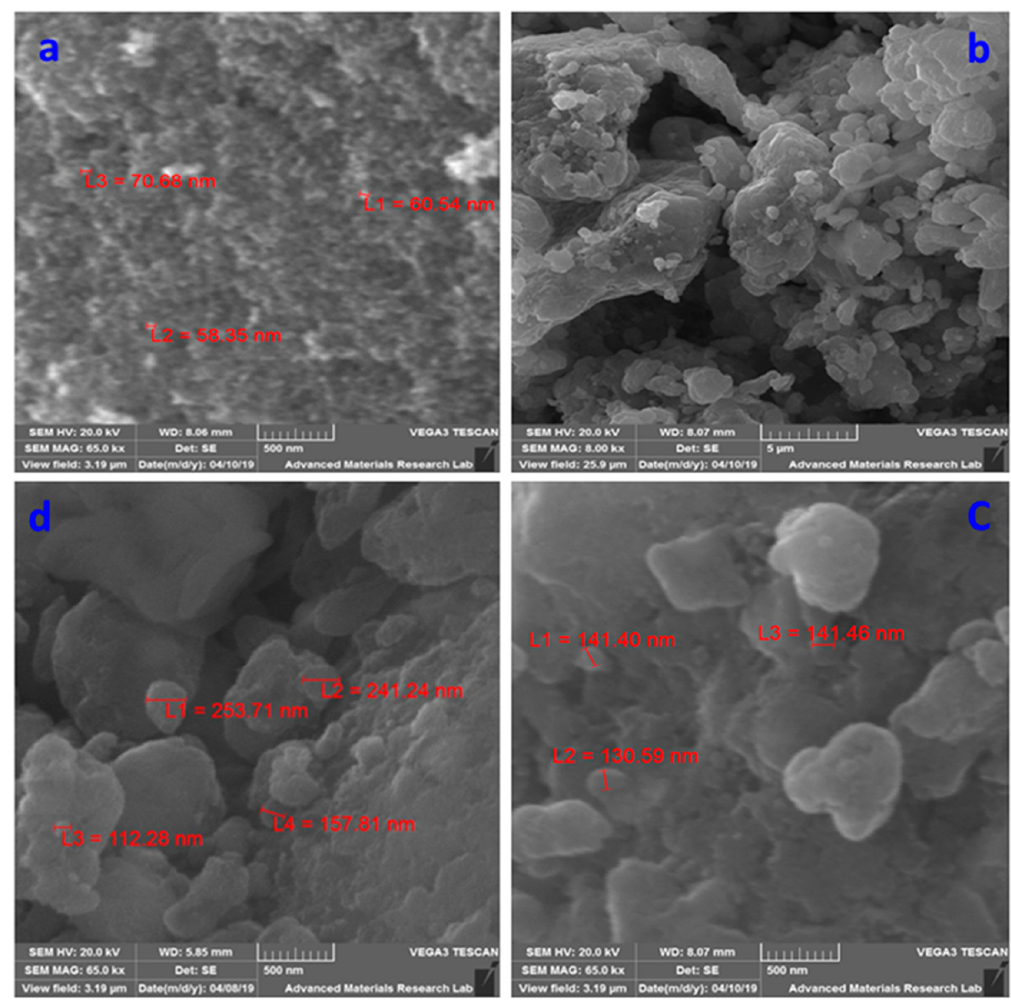
ff erent magnification; ( c ) catalyst Fe 3 O 4 ; ( b ) Fe 3 O 4 in di